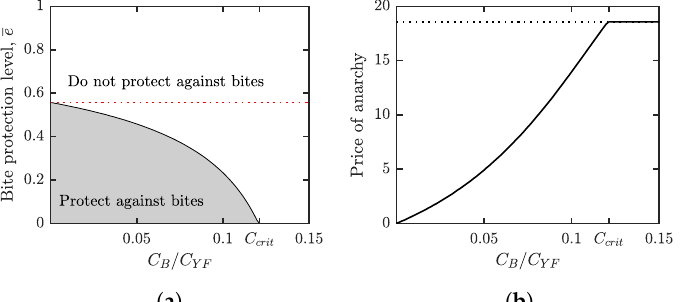
Figure 5. ( a ) Parameter regions where voluntary bite protection is beneficial (gray) and not beneficial (white). The boundary between the two regions represents the optimal voluntary bite protection level, e NE . The red dotted line is the bite protection level needed for YF elimination, e HI . As C B / C YF increases, e NE decreases while e HI remains constant. When C B / C YF reaches the critical level C crit , e NE becomes 0, i.e., at that point, the relatively high cost of bite protection makes “do not protect against bites” an optimal strategy from the individuals’ perspective. ( b ) The price of anarchy is again evaluated as the number of new symptomatic yellow fever infections per year per 10 4 population when individuals use the Nash equilibrium level of protection. As C B / C YF increases, the difference between e HI and e NE grows. This means that the number of price of anarchy increases. When C B / C YF reaches the critical level C crit , e NE becomes 0 and the price is maximal (shown by the dotted line). In both figures, p = 0 and the values of all other parameters are as in Table